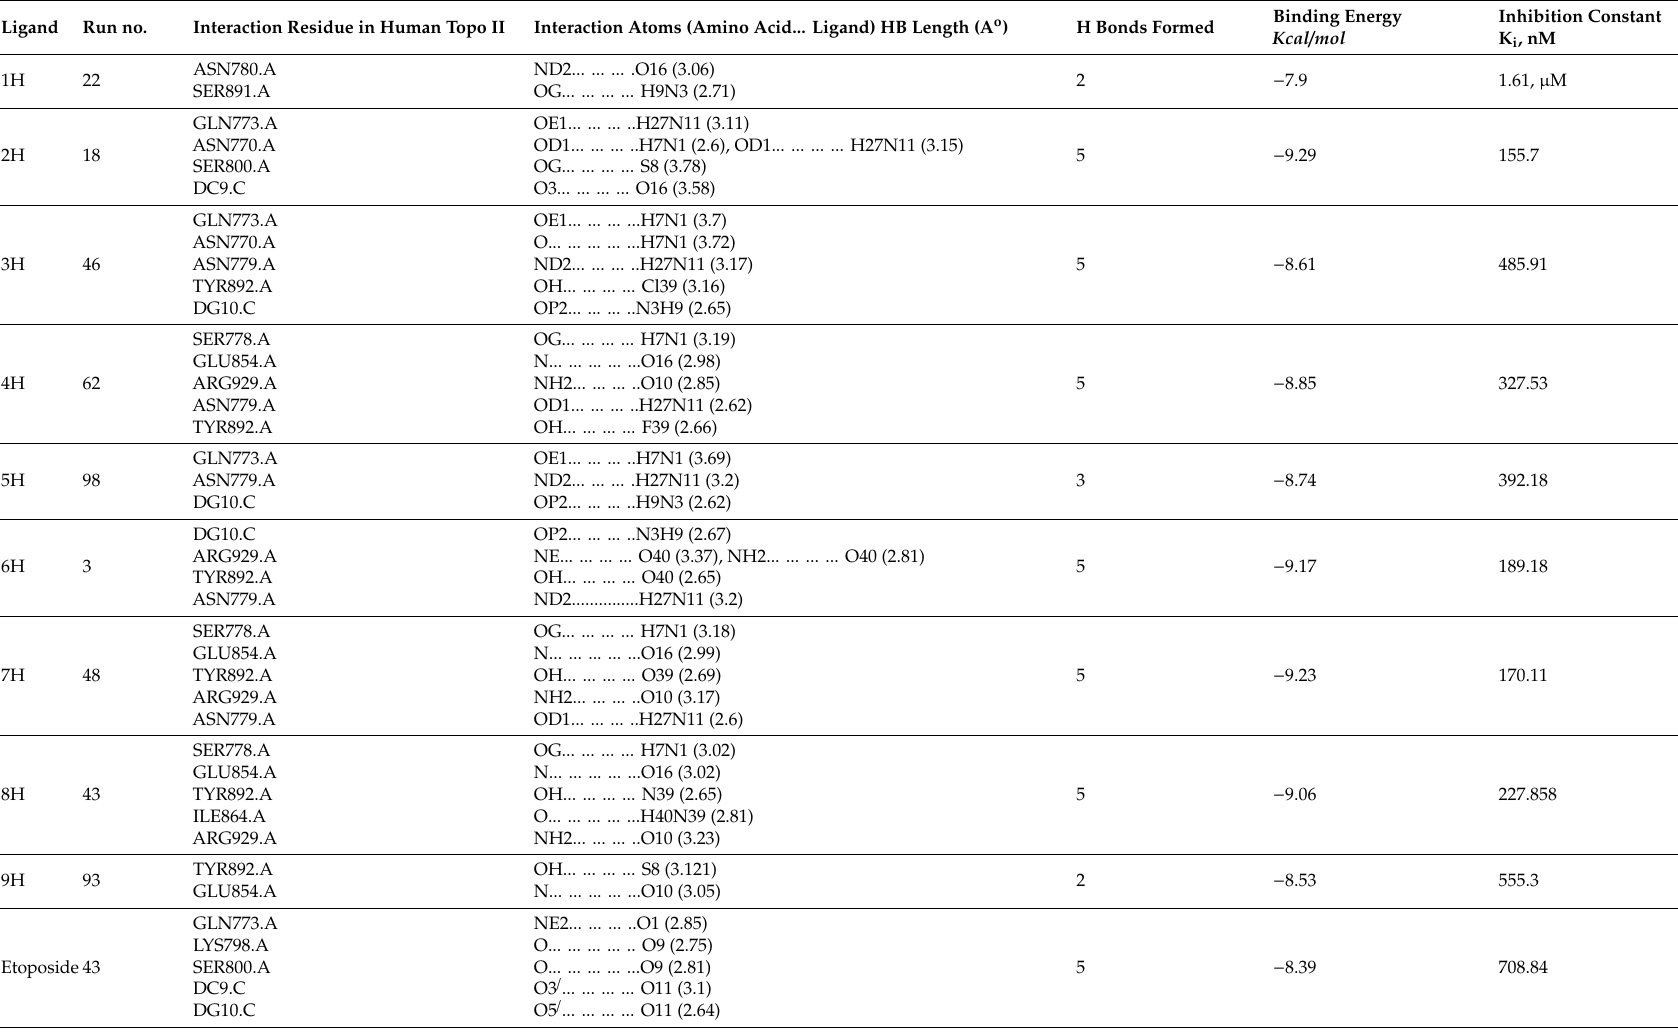
Table 6. Molecular interactions of the nine derivatives of TUDHIPP (1H − 9H) with human-DNA topoisomerase II α (4fm9). Ligand Run